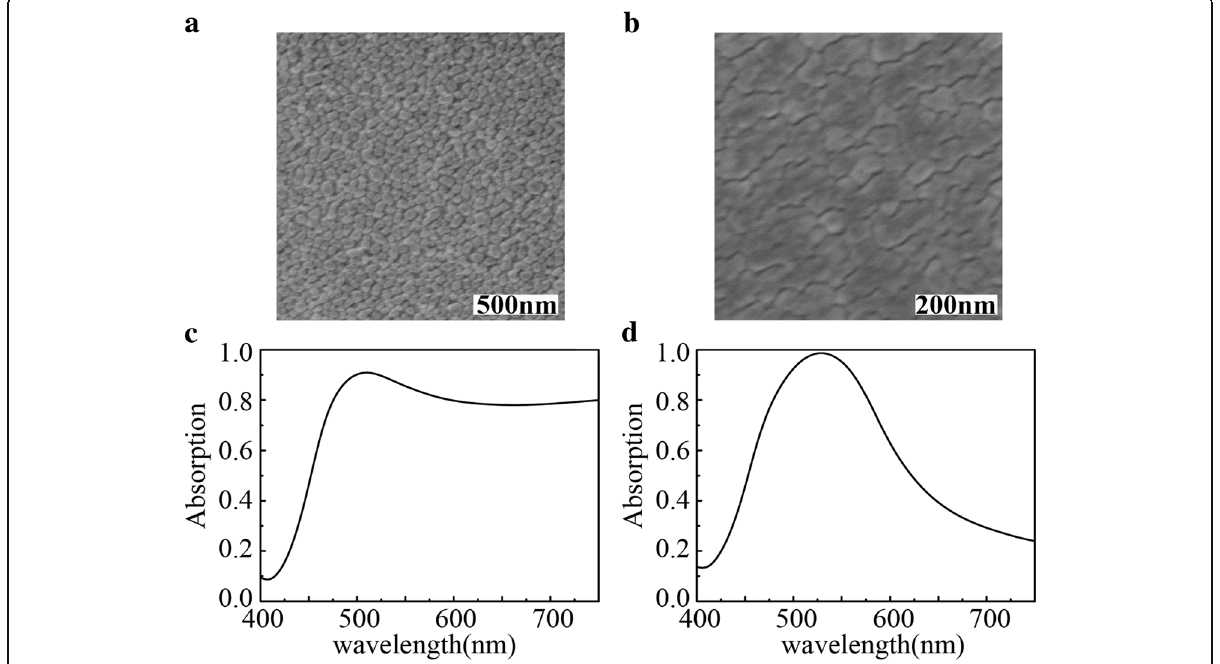
bottom metal film. The field distribution of the Ag and